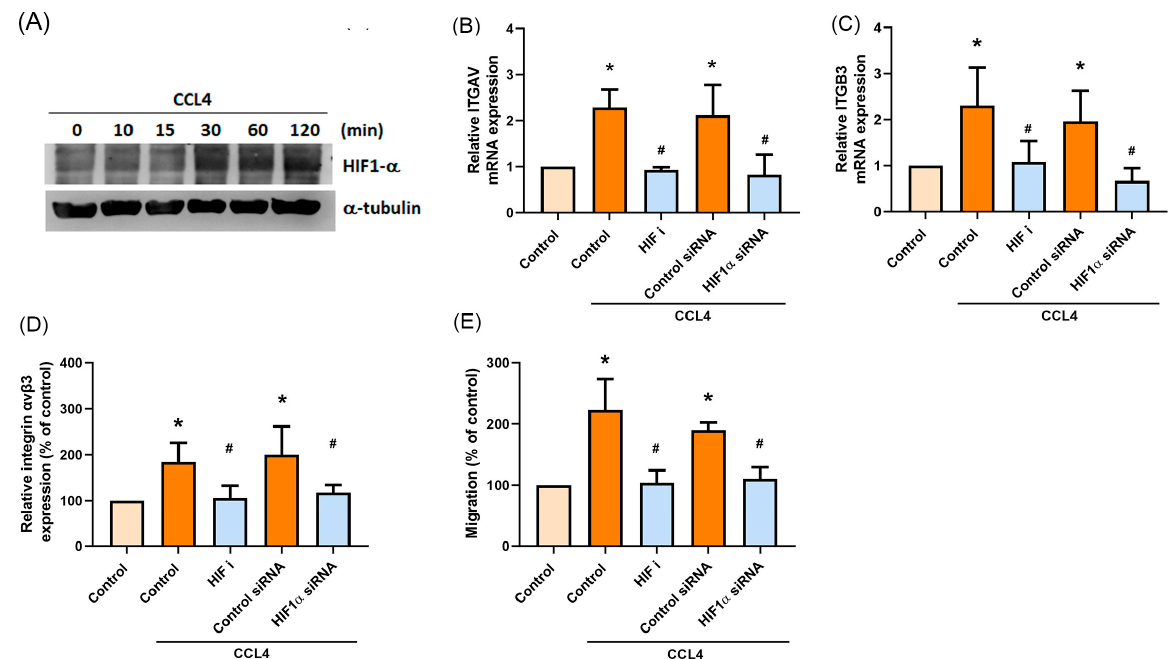
Figure 5. HIF-1 α is involved in CCL4-mediated expression of integrin α v β 3 expression and migratory activities of osteosarcoma cells. ( A ) 143B cells were incubated with CCL4 (30 ng/mL) for the indicated time intervals, then HIF-1 α activation was examined by the Western blot assay. ( B – E ) 143B cells were treated with an HIF-1 α inhibitor (HIF i; 10 µ M) for 30 min, or transfected with HIF-1 α siRNA, then stimulated with CCL4 (30 ng/mL) for 24 h. Levels of ITGAV mRNA ( B ) and ITGB3 mRNA expression ( C ), cell surface integrin α v β 3 protein expression ( D ), and cell migratory abilities ( E ) were examined by qPCR, flow cytometry, and the Transwell assay, respectively. The results were obtained from three independent experiments and are expressed as the means ± SD. * p < 0.05 compared with controls; # p < 0.05 compared with CCL4-treated controls.